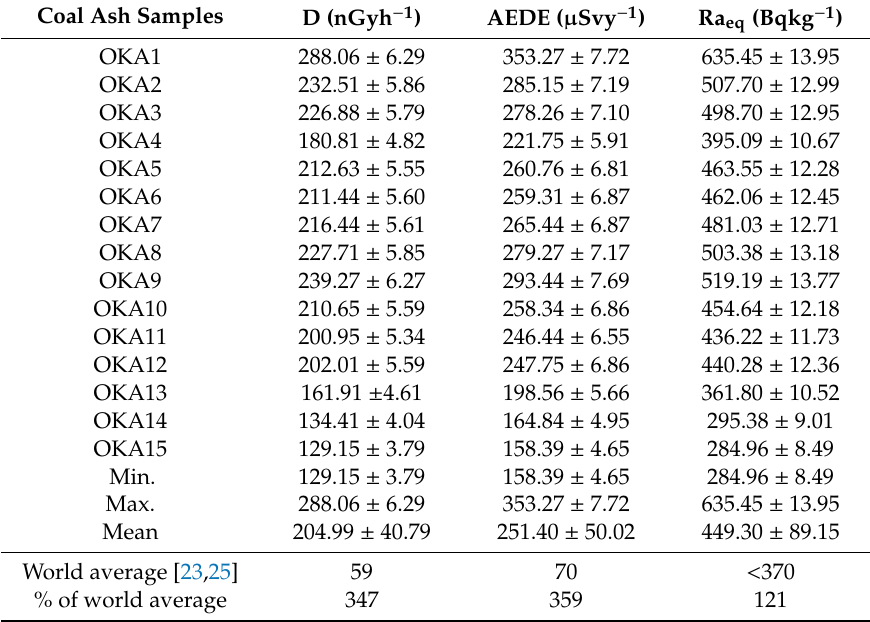
Table 7. Radiological hazard indices for radionuclides in Okaba simulant coal ash samples. Coal Ash Samples